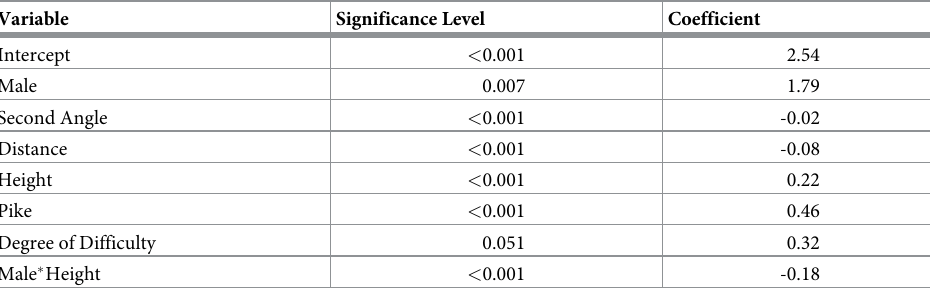
Table 2. The final model’s coefficients and p-values associated with the